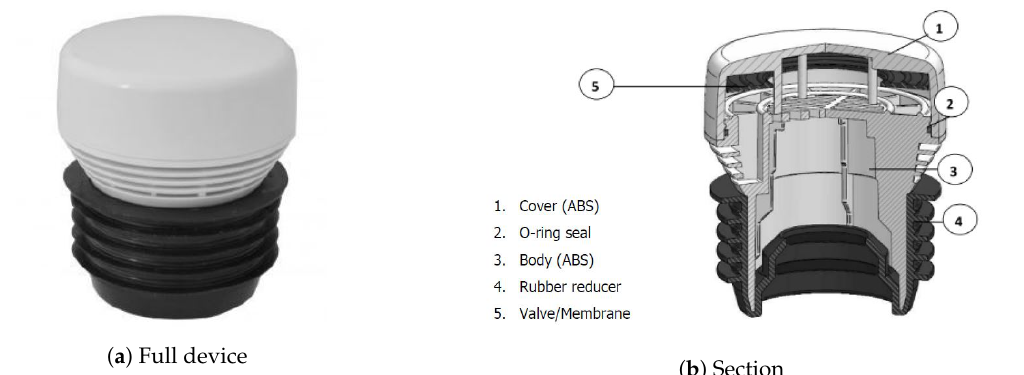
Figure 13. MiniHab HypAirBalance from Capricorn used in the Tupperwave small-scale